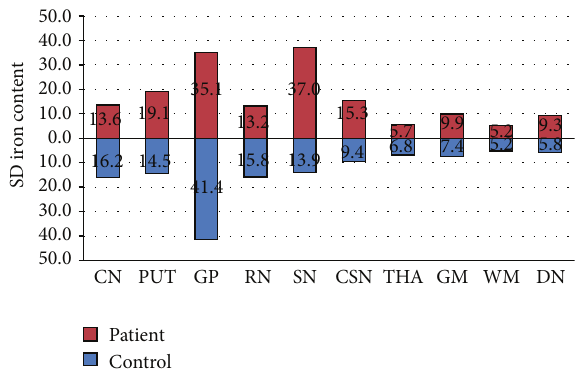
Figure 2: Heterogeneity of phase values at different ROIs with an exaggerated trend at SN in PD